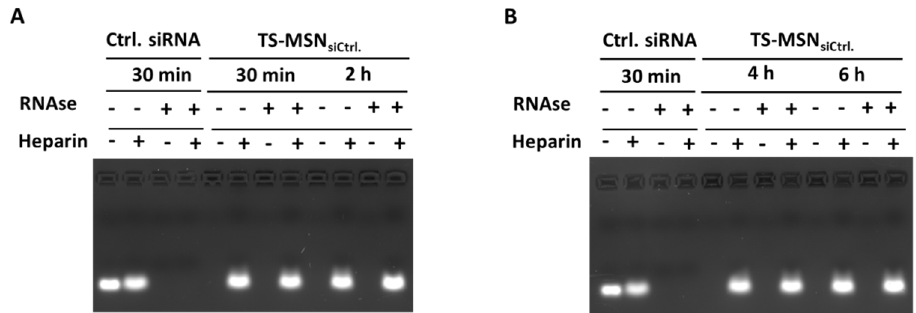
Figure 4. Gel retardation assay demonstrating the siRNA protection against RNAse degradation. siRNA formulated in TS-MSN ( A ) for 30 min and 2 h and ( B ) for 4 and 6 h, in the presence (+) or absence (-) of RNAse A and/or heparin compared to naked non-vectorized siRNA incubated for 30 min. Lanes without heparin show free siRNA amount, and lanes with heparin show total siRNA amount in the sample. TS-MSN: targeted stealth magnetic siRNA nanovectors.